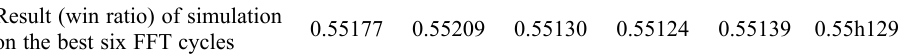
Table 3. Resulting win ratios of an agent trading on six best FFT cycles